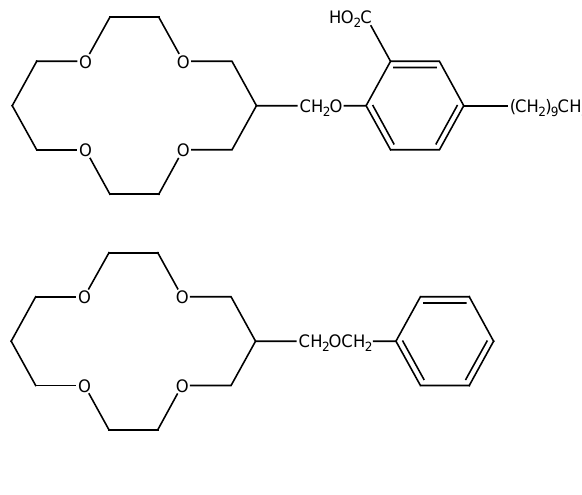
Figure 28. Proton-ionizable and neutral crown